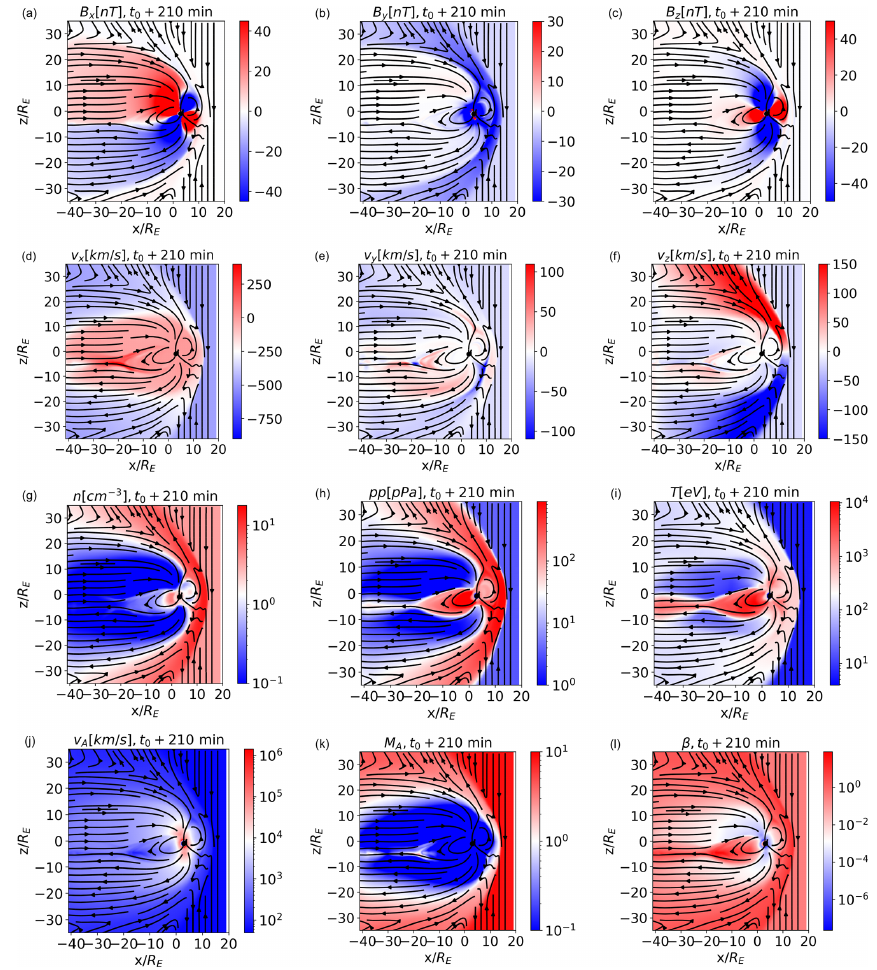
Figure 1. Simulated magnetospheric variables in the y/R E = 0, meridional, plane and at t 0 + 210min. The different magnetospheric regions are evident. Magnetic field lines are depicted as black